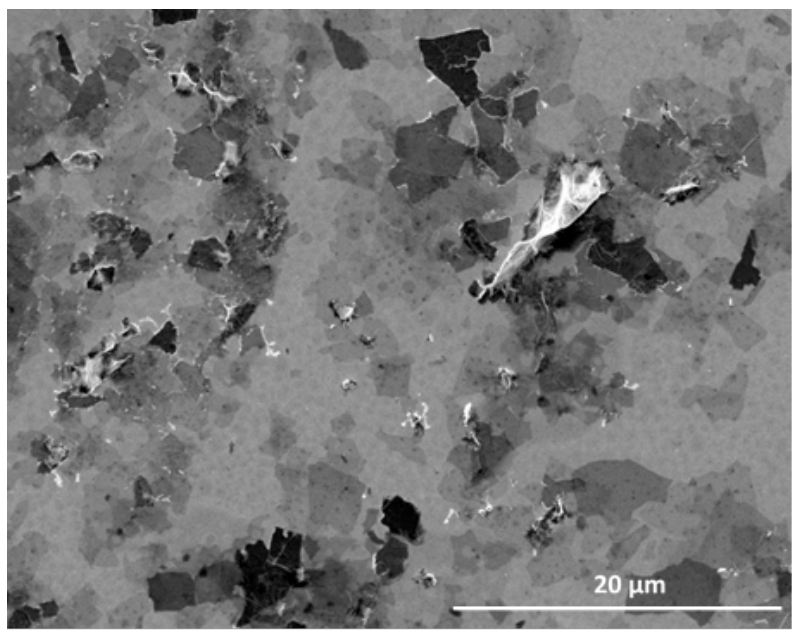
Figure 8. SEM image of GO. Magnification: 5000×, scale bar: 20